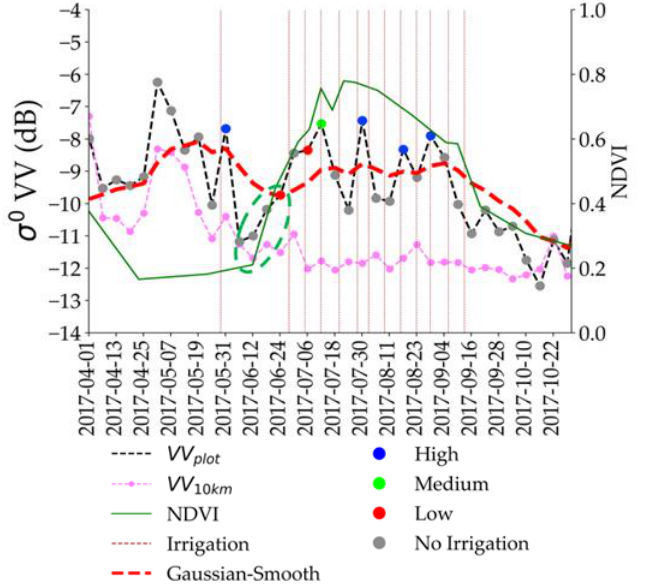
Figure 6. Effect of smoothed-Gaussian filter on the detection of irrigation points for plot P2, Montpellier. The red dashed curve represents the 𝜎 𝑠𝑚𝑜𝑜𝑡ℎ0 calculated as each SAR date.